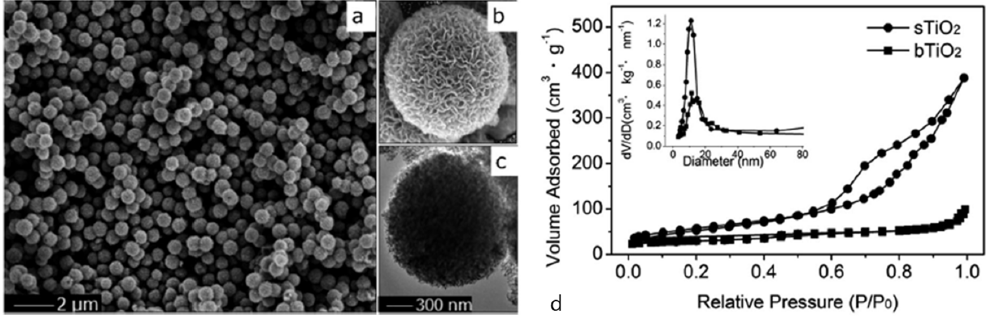
Figure 7. The ( a ) SEM, ( b , c ) TEM images and ( d ) N 2 adsorption-desorption isotherm of spherical (sTiO 2 ) and bulk (bTiO 2 ) samples (inset pore size distribution), reprinted with permission from [100].